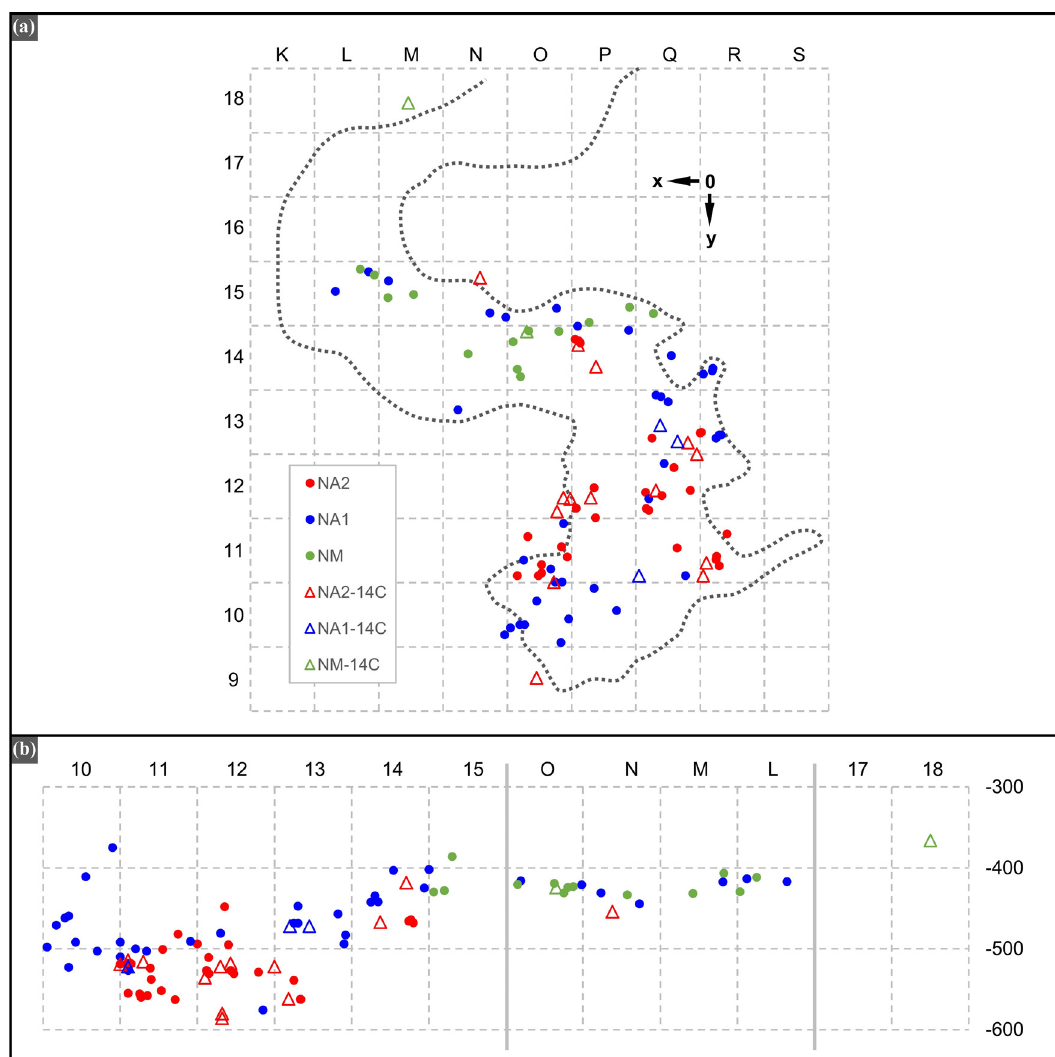
Figure 5: Gruta do Caldeirão. Spatial distribution of Neolithic diagnostics and associated radiocarbon - dated samples. ( a ) Horizontal scatter plot. ( b ) Vertical projection along the axis of the passage ( elevations in cm below datum ) . NA2 = Cardial; NA1 = Epicardial; NM = Middle